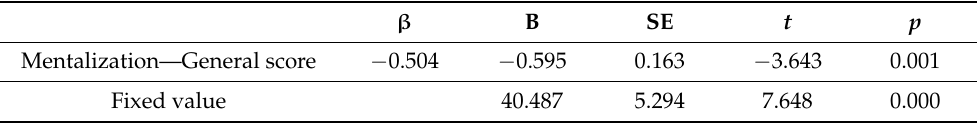
Table 4. Predictors of satisfaction with life.